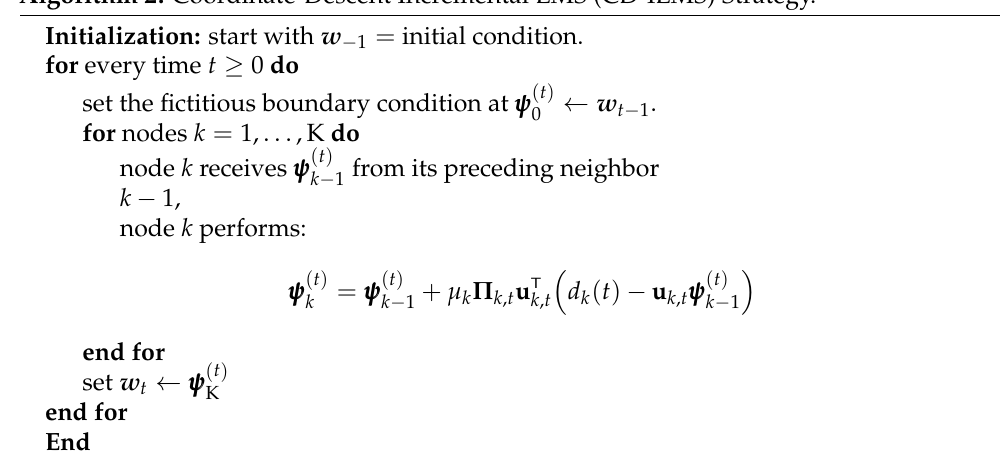
Algorithm 2. Coordinate-Descent Incremental LMS (CD-ILMS)